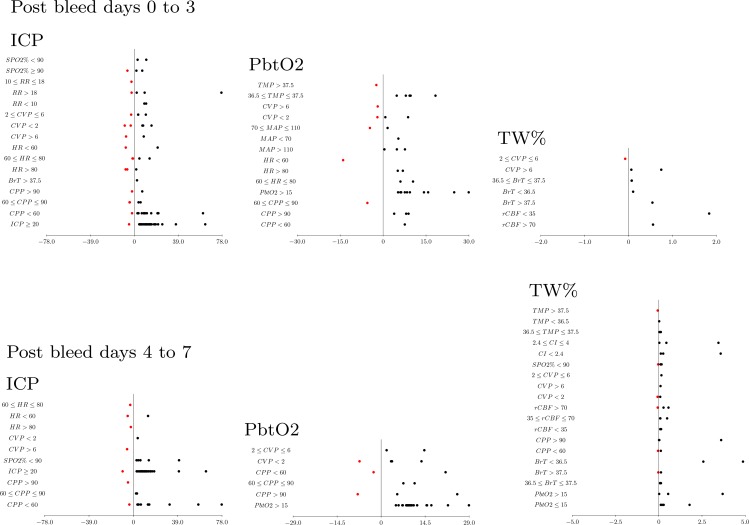
Directionality and effect size of causal inferences.Data is displayed for intracranial pressure (ICP), partial brain tissue oxygenation (pbtO2), and total brain water content (TW%; each dot signifies one patient; red dots indicated a decrease and a black dot an increase in the variable of interest).